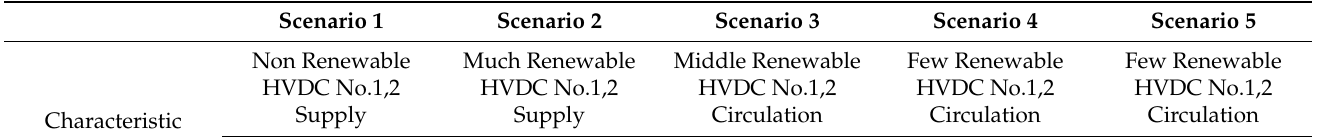
Table 12. Scenario C configuration (HVDC No.3 transmission).